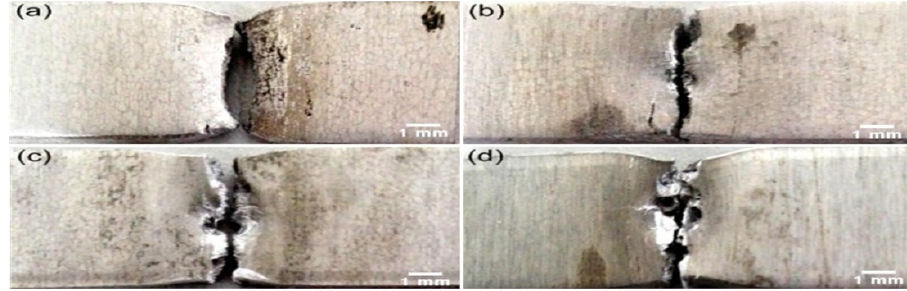
Figure 7. Rupture morphology of the Al-7075 specimens fractured under the conditions of 1.1 kW/cm 2 laser power density and various preloaded speeds of ( a ) 0.5 mm/Min; ( b ) 1 mm/Min; ( c ) 2 mm/Min; ( d ) 4 mm/Min.